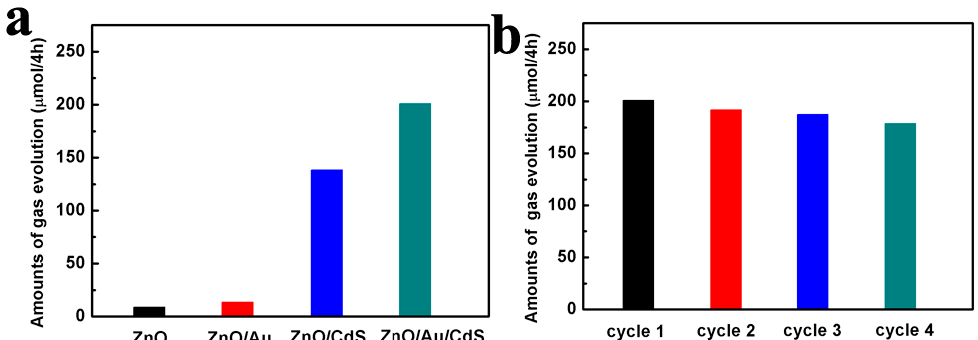
Figure 8. ( a ) The amounts of gas evolution of the ZnO, ZnO/Au, ZnO/CdS and ZnO/Au/CdS samples (100 mg of catalyst for 4 h); ( b ) the cycling stability of the ZnO/Au/CdS photocatalyst (4 h as a cycle).